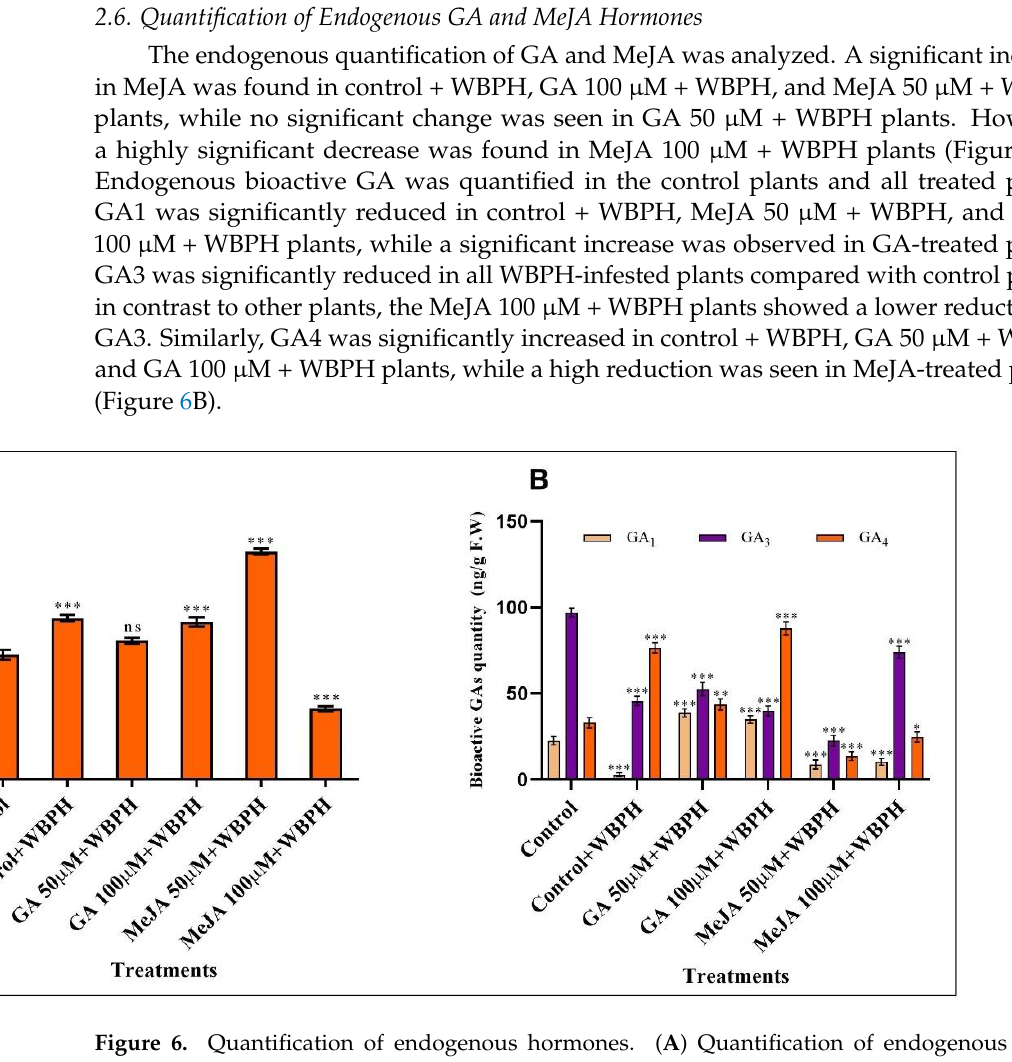
Figure 6. Quantification of endogenous hormones. ( A ) Quantification of endogenous MeJA. ( B ) Quantification of bioactive GAs (GA1, GA3, and GA4). Error bars represent the standard error of the mean data ( n = 3); ns represents not significant, and asterisks denote a significant difference (* p < 0.05; ** p < 0.01; *** p < 0.001), according to the analysis using two-way ANOVA and the Bonferroni post hoc test. The experiments were repeated three times.